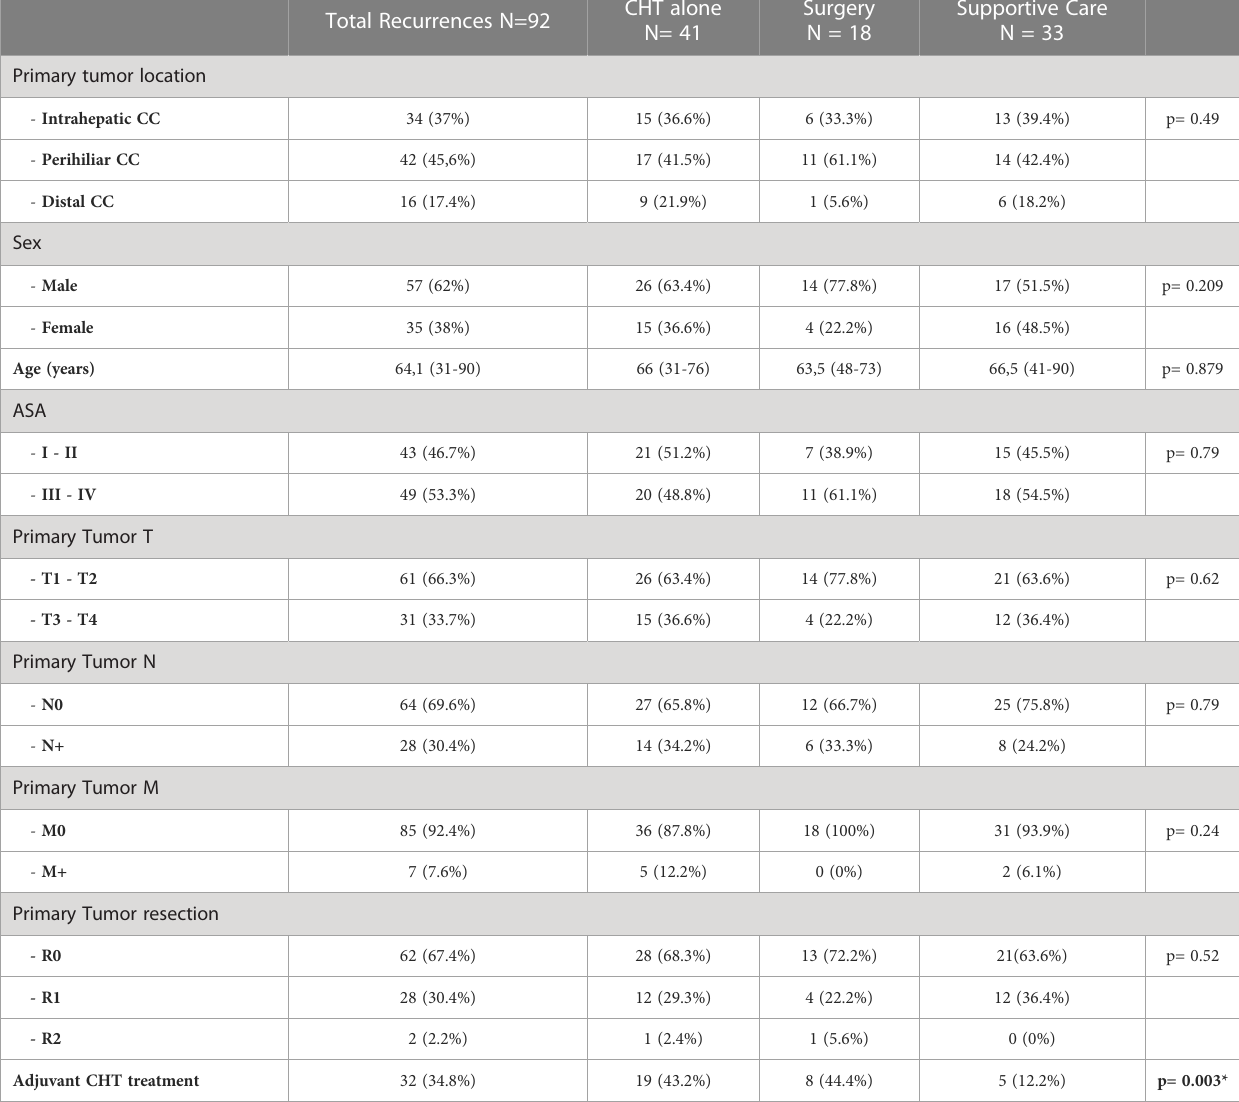
Total Recurrences N=92